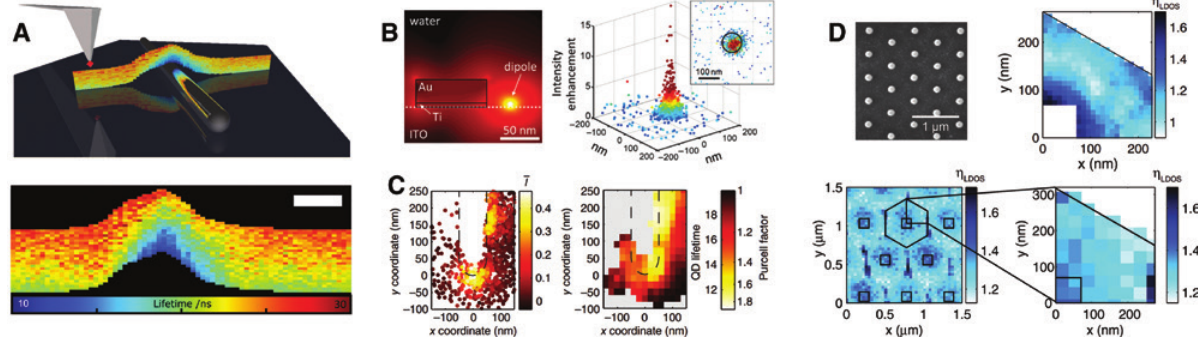
Figure 16: Probing the Purcell effect with nanoscale spatial resolution. (A) Local density of states (LDOS) mapping using single nitrogen-vacancy center in a nanodiamond attached to an atomic force microscope (AFM) tip. Two-dimensional stripe scan across a silver nanowire enables the extraction of the lifetime of a quantum emitter as a function